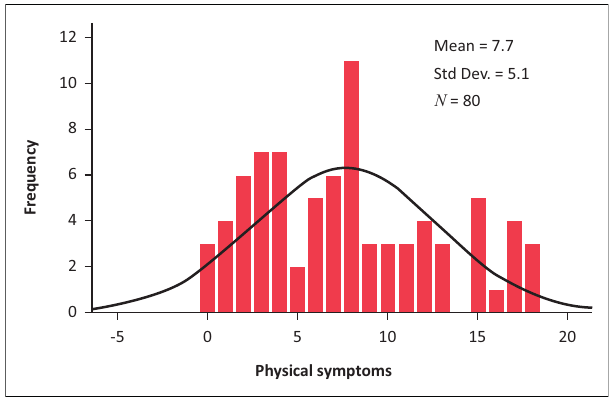
FIGURE 2: Physical symptoms of